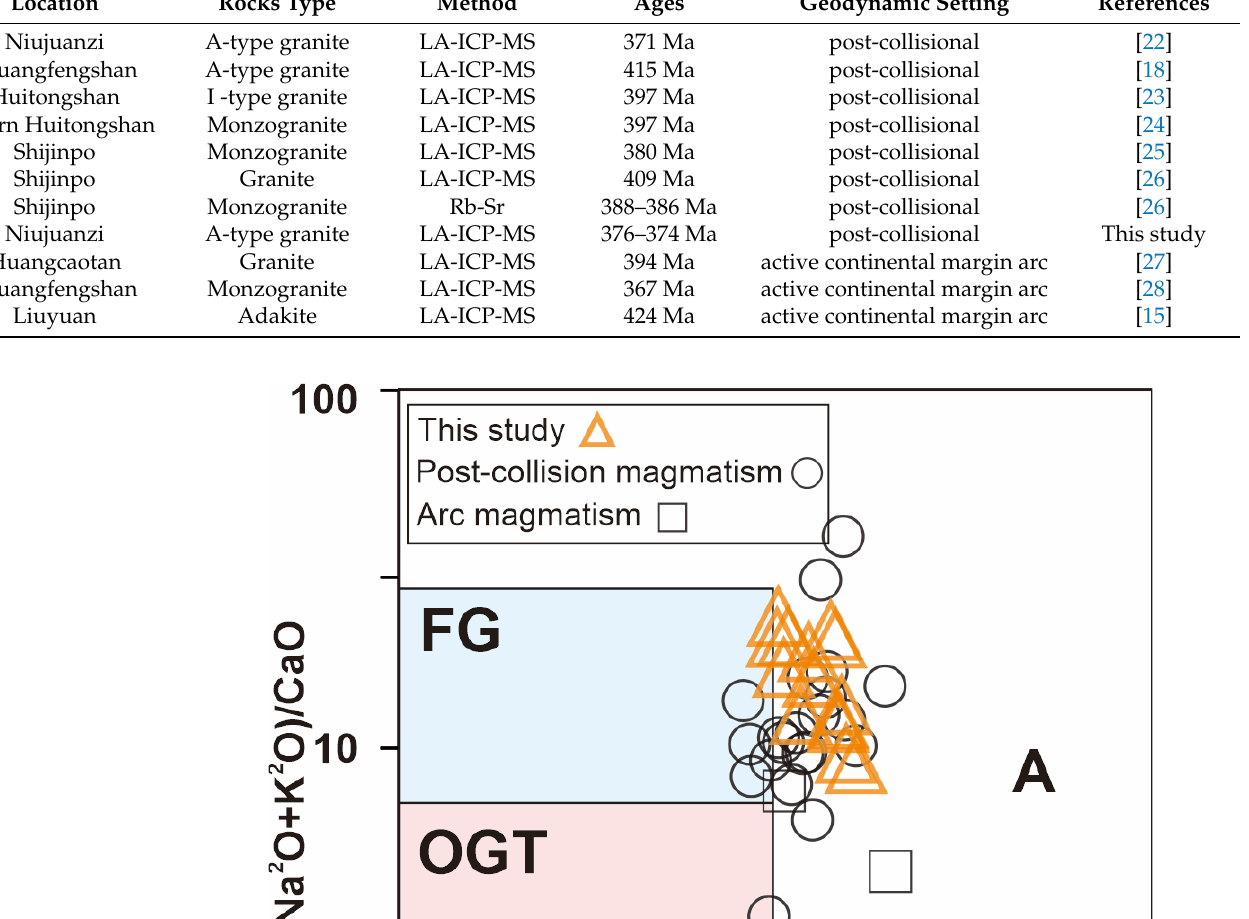
Table 1. Summary of petrological and ages for granitoids in the middle Huaniushan arc.